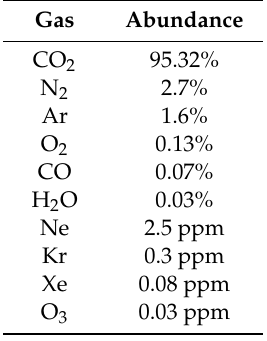
Table 2. Composition of the Martian lower atmosphere